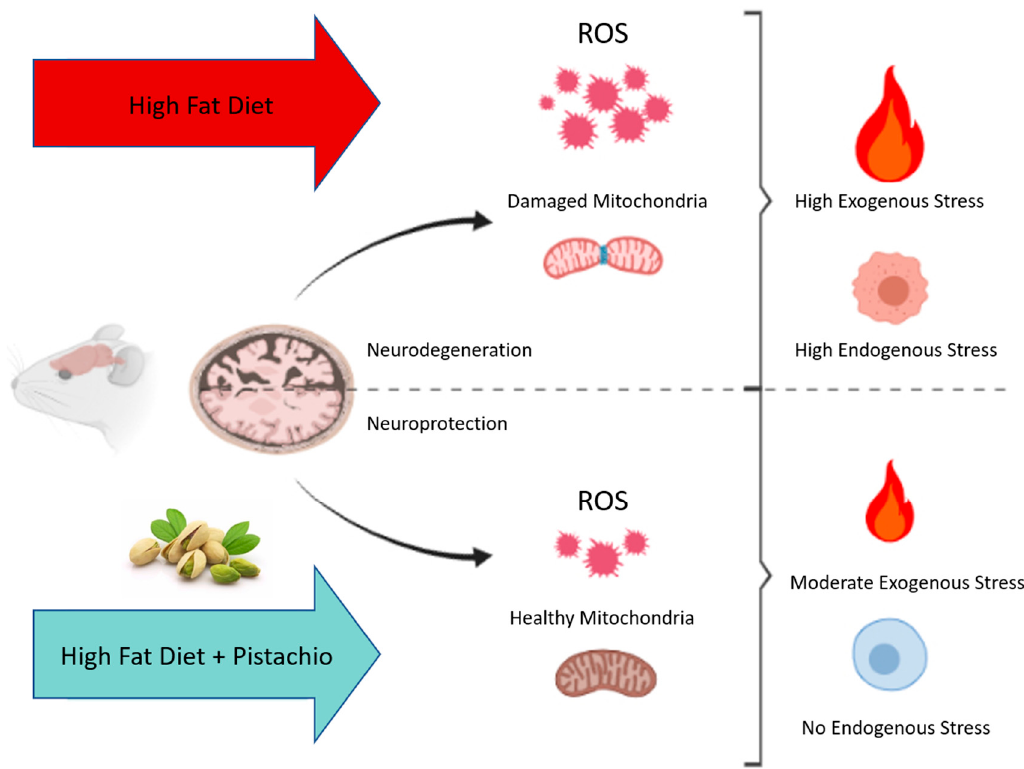
Figure 6. Schematic representation of the neuroprotective effect of regular pistachio intake.